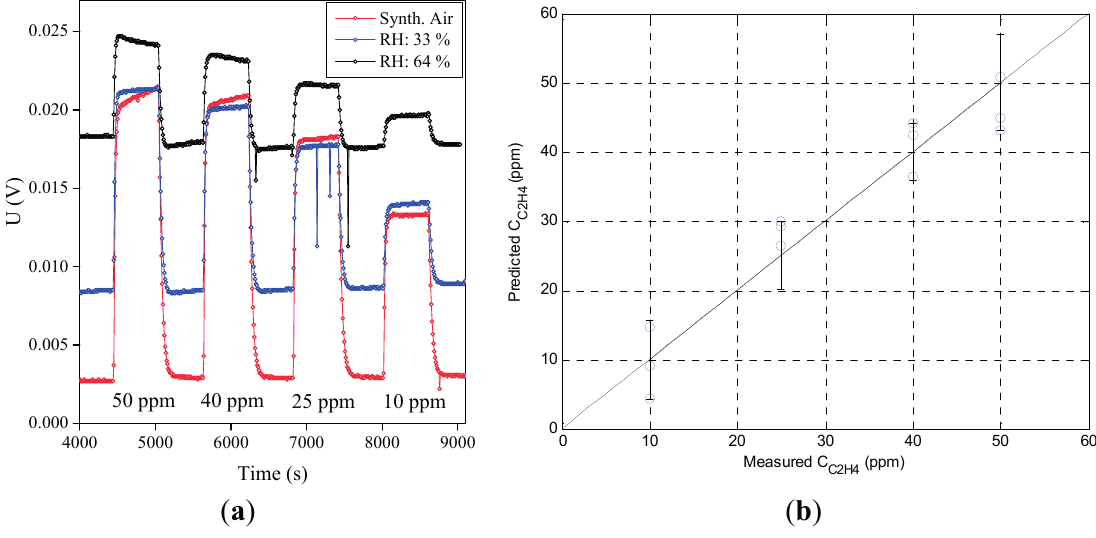
Figure 6. ( a ) Response and recovery measurements of MiCS-5914 sensor with longer stabilization (4500 s) at different relative humidity; ( b ) The corresponding combined prediction model as a linear function of the concentration, relative humidity, and their